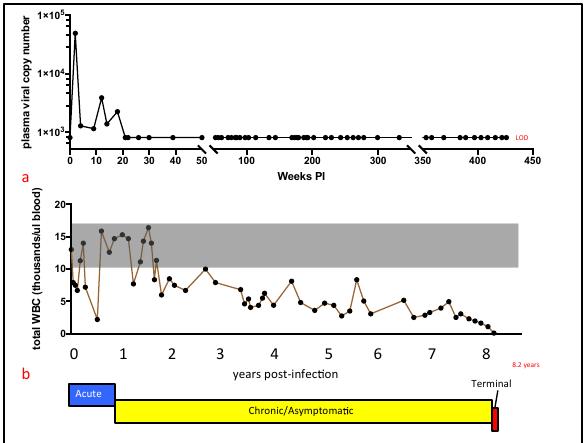
Figure 1. Plasma viral copy number, total white blood cells (WBC), and clinical trajectory of cat 165. ( a ) The plasma viral copy number is plotted as number of copies gag RNA/mL blood vs weeks post- infection (PI). The limit of detection (LOD) is approximately 800 copies vRNA/mL blood. ( b ) The total number of WBC (in thousands of leukocytes/microliter blood) is plotted against years PI—8.2 years (red X) is the time of euthanasia PI. The clinical trajectory of FIV for cat 165 is depicted below the x-axis- acute stage (blue), asymptomatic stage (yellow) and terminal stage (red).